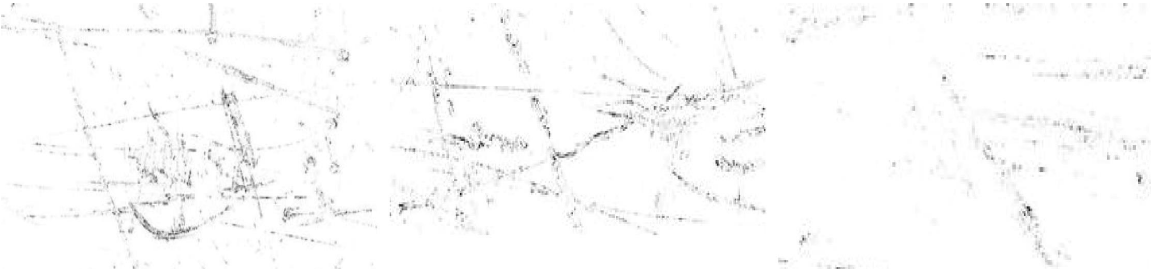
Figure 6: Generation and erasure process of domain wall imprints.